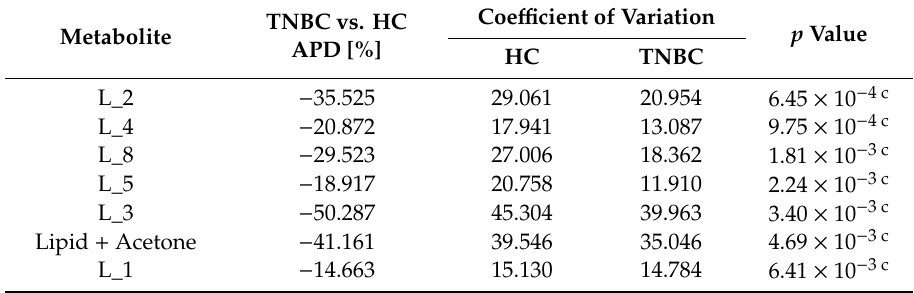
Table 3. Percentage change between statistical significance assigned signals originating from the lipid fraction in the HC and TNBC serum, sorted by p -value.